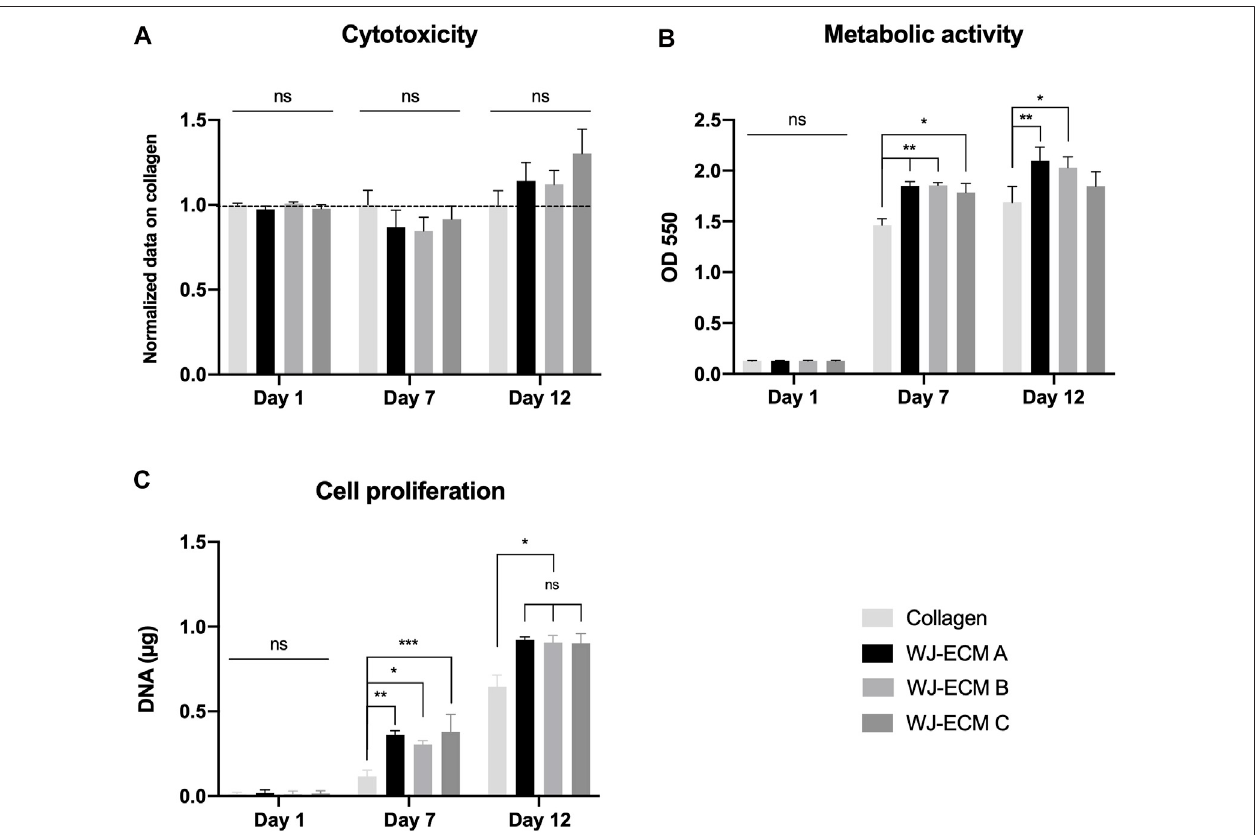
FIGURE 5 | Study of the cytocompatibility of WJ-ECMaa coating with h-WJ-MSC. WJ-MSC were seeded and expanded on WJ-ECMaa and collagen coatings, and cell behavior was evaluated at 1, 7, and 12 days of culture. (A) Cytotoxicity of the coating was evaluated by release of LDH by cells. For each day, results were normalized to collagen-induced cytotoxicity. (B) Metabolic activity of WJ-MSC observed at days 1, 7, and 12 according to the coating. (C) Monitoring of the cell proliferation rate by DNA quanti fi cation at days 1, 7, and 12 according to the seeded coating. Results are presented as the mean ± SEM for each condition, and were statistically analyzed following two-way ANOVA ( p -value: * < 0.05, ** < 0.01, *** < 0,001); n = 3.